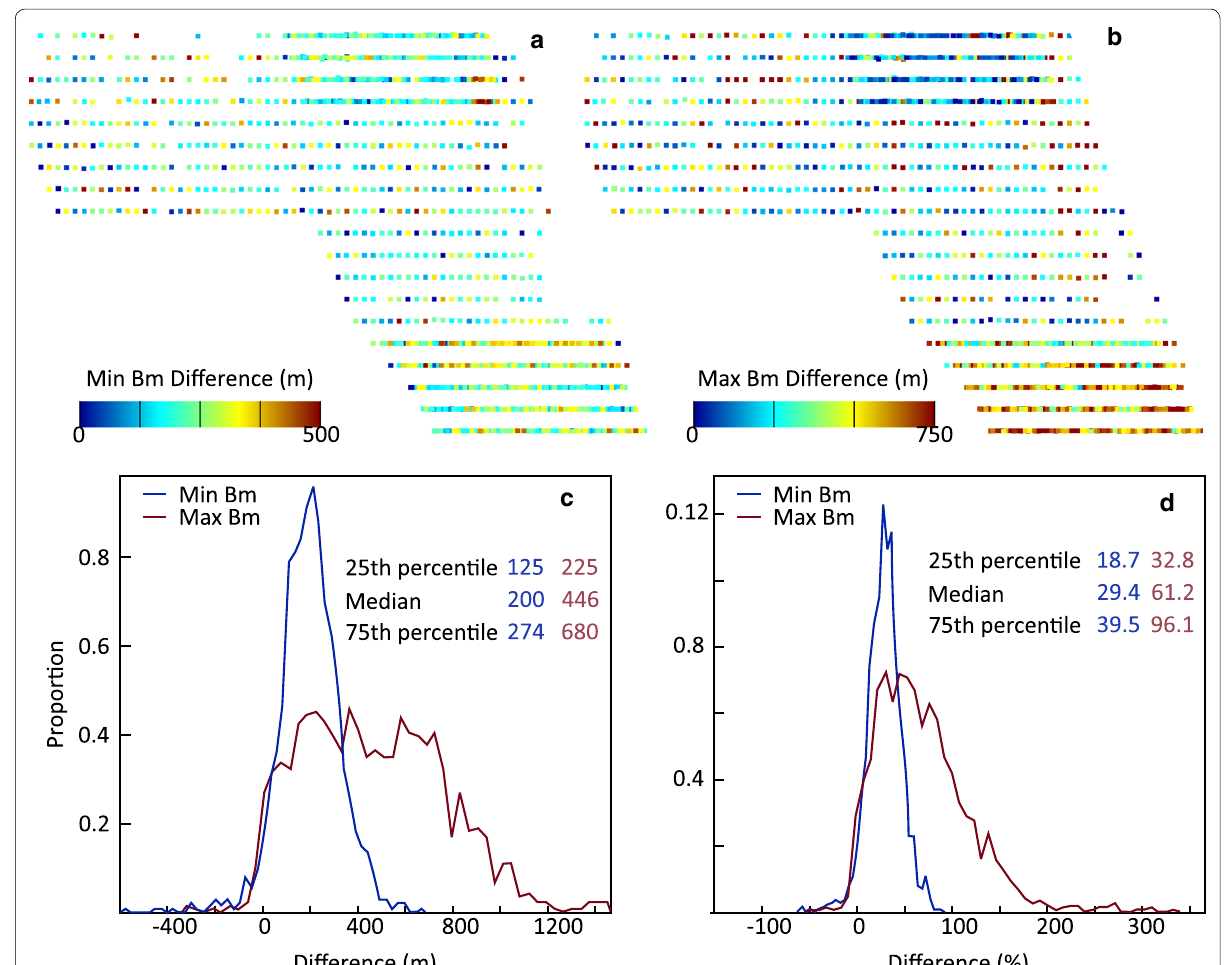
Fig. 12 Uncertainty of basement interface. a Calculated difference between the base Georgina (basement) surface at the Bm Min at each site. b Calculated difference between the base Georgina (basement) surface at the Bm Max at each site. c Histogram distribution of the difference ( m ) between the Bm Min and Bm Max and the final interpretation at each MT site. d Histogram distribution of the difference (%) between the Bm Min and Bm Max and the final interpretation at each MT